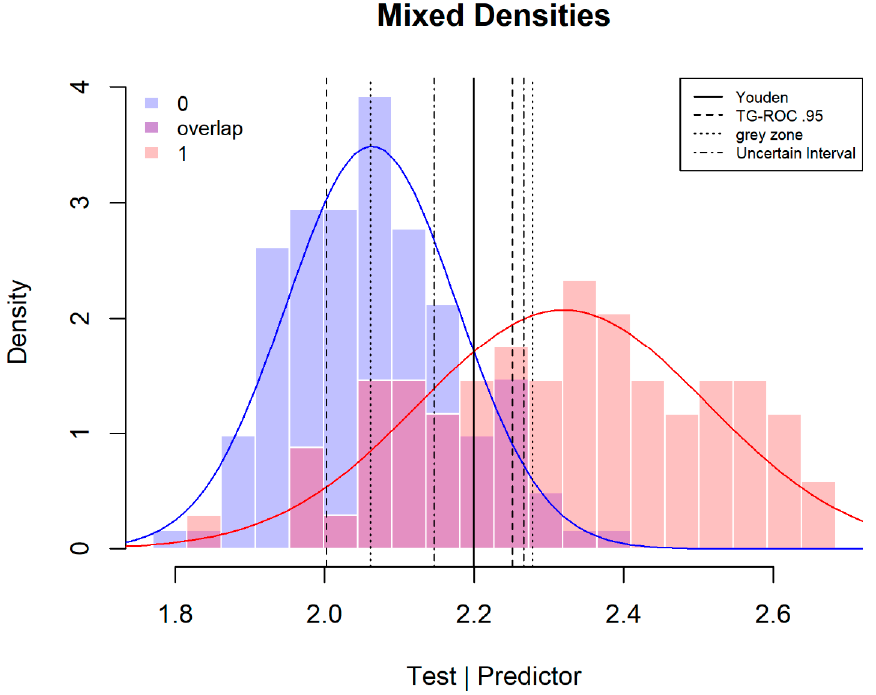
Figure 2. The threshold of the three methods applied to scores of the serum marker CK for the determination of Duchenne muscular dystrophy (DMD) carriers. The receiver operating curve (ROC) (0, 1) threshold is near to the Youden threshold (not displayed).